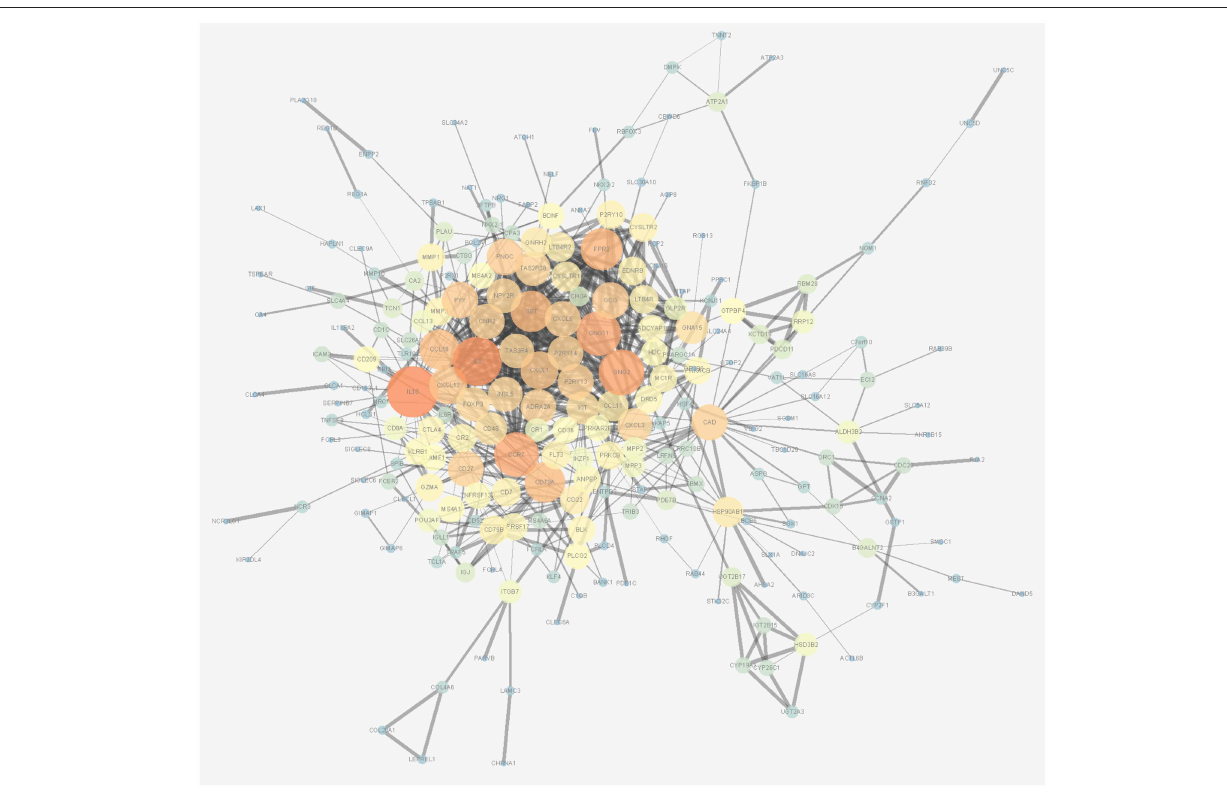
Frontiers in Oncology |